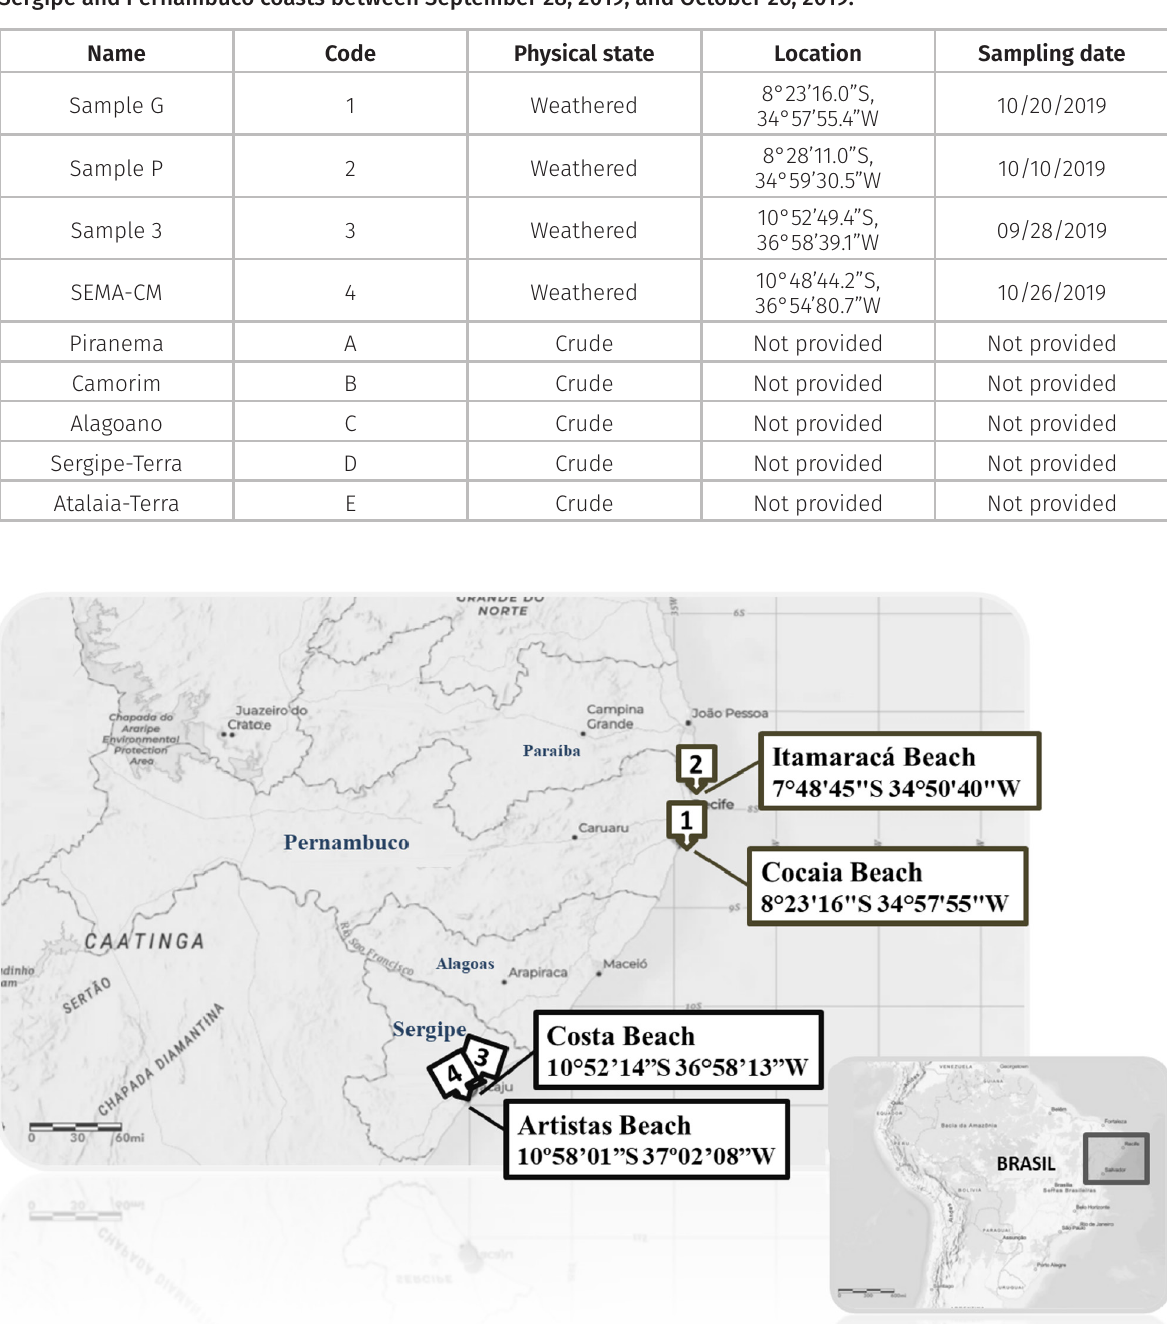
Figure 1. Map showing the oil sample collection locations on the coasts of the states of Sergipe and